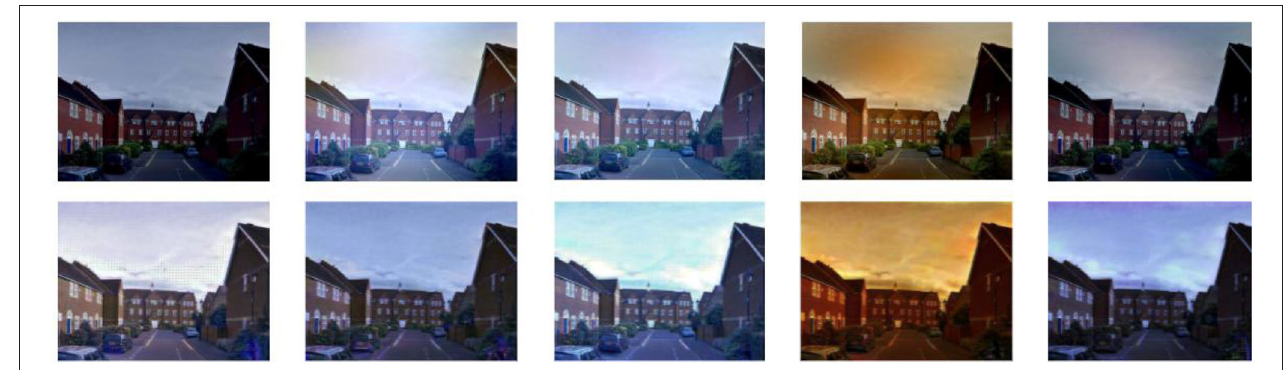
FIGURE 5 | Qualitative comparison between AdAGeo and AdAGeo-Lite data augmentation methods: on the first row, the RobotCar images are augmented with the DDDA method from AdAGeo-Lite, on the second row the augmentation is performed with AdAGeo. The columns, from left to right, refer to the following target domains: Snow, Rain, Sun, Night, and